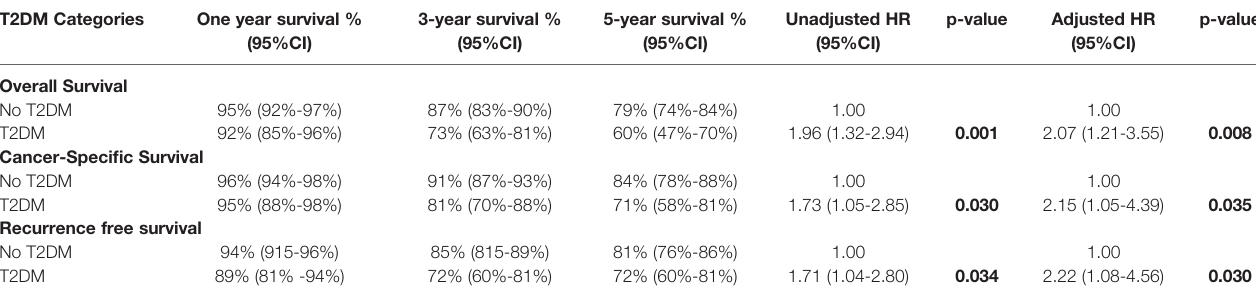
TABLE 3 | Cox regression analyses of T2DM status and endometrial cancer survival outcomes with crude and adjusted hazard ratios and 95% con fi dence intervals. T2DM Categories